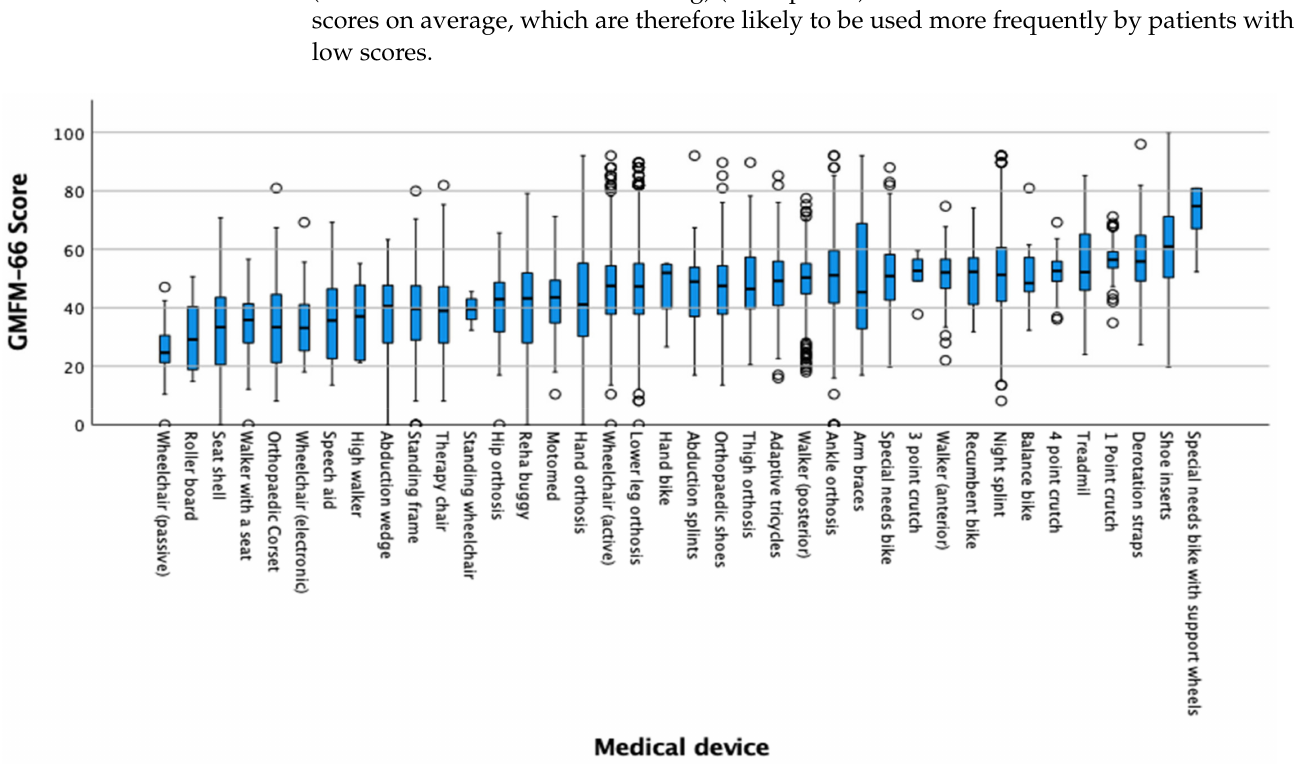
Figure 1. Statistical distribution of aids: Boxplot of the GMFM-66 scores of the different medical devices in descending